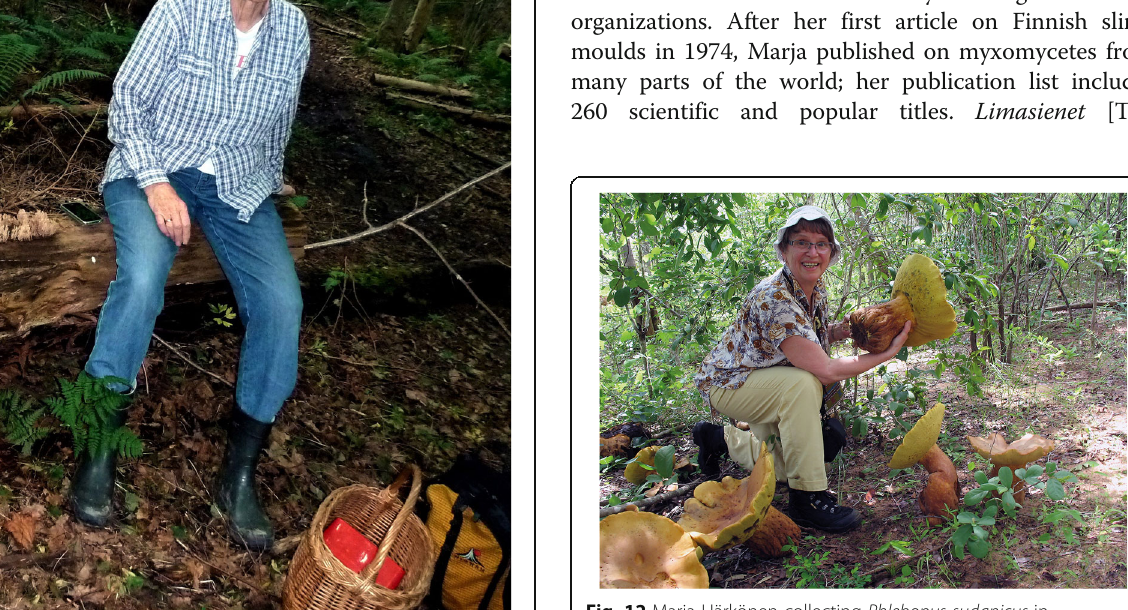
Fig. 12 Marja Härkönen collecting Phlebopus sudanicus in Mozambique,